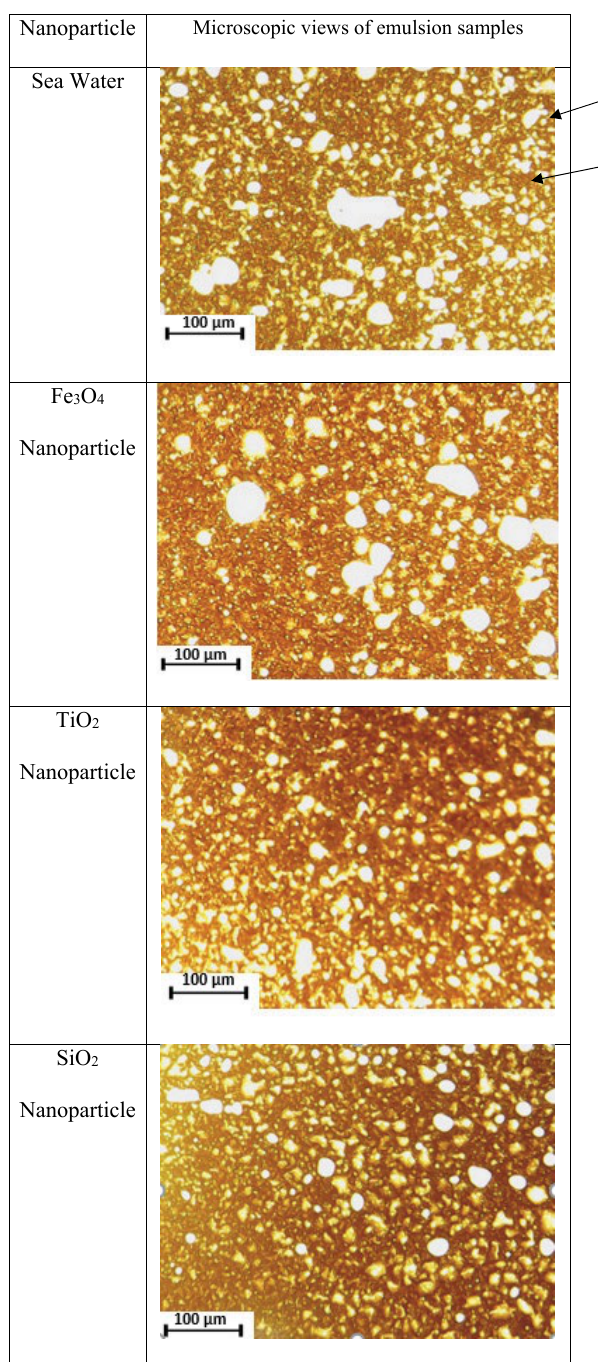
Fig. 7. Microscopic views of emulsion samples Fig. 7: Microscopic views of emulsion